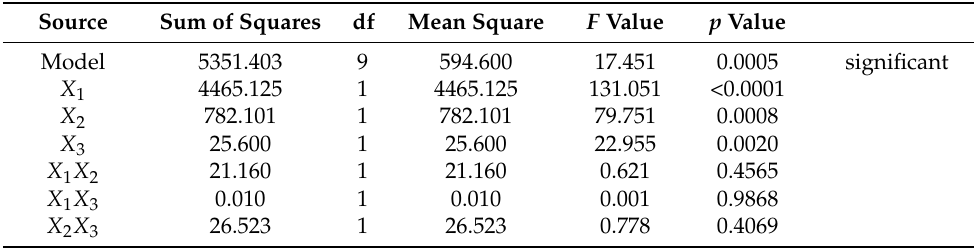
Table 1. Analysis of variance for the response surface